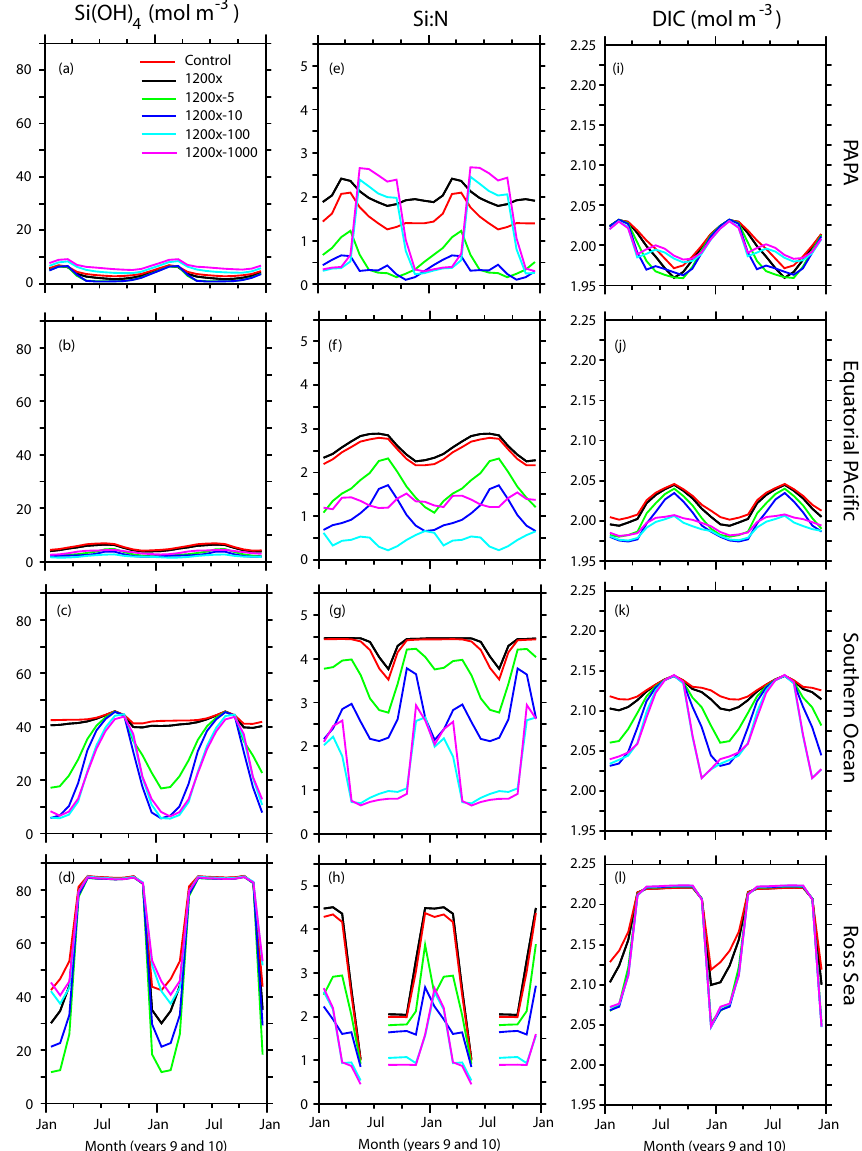
Fig. 15. Mean silicic acid, Si:N, and DIC in the top 10m of the four fertilization sites after 10 years of constant fertilization with increasing additions of iron expressed here as a multiple of the standard 1200x